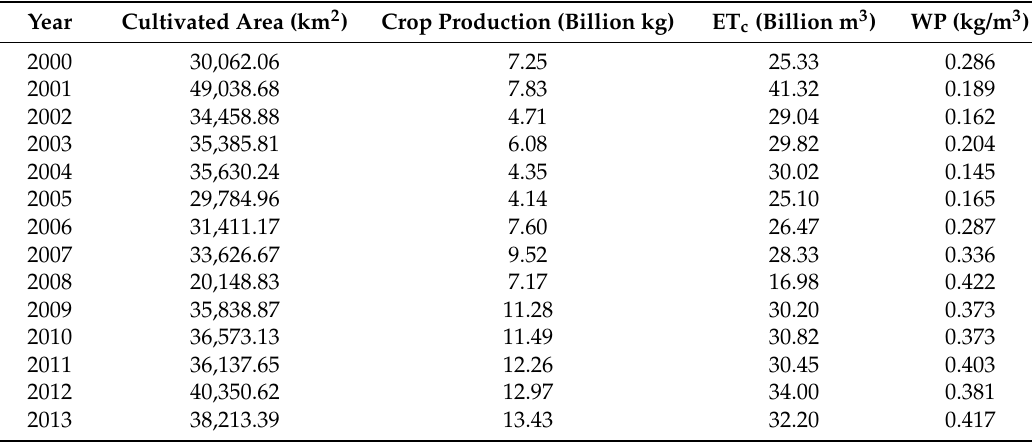
Table 2. Water productivity calculated from total crop yield in Malawi. Year